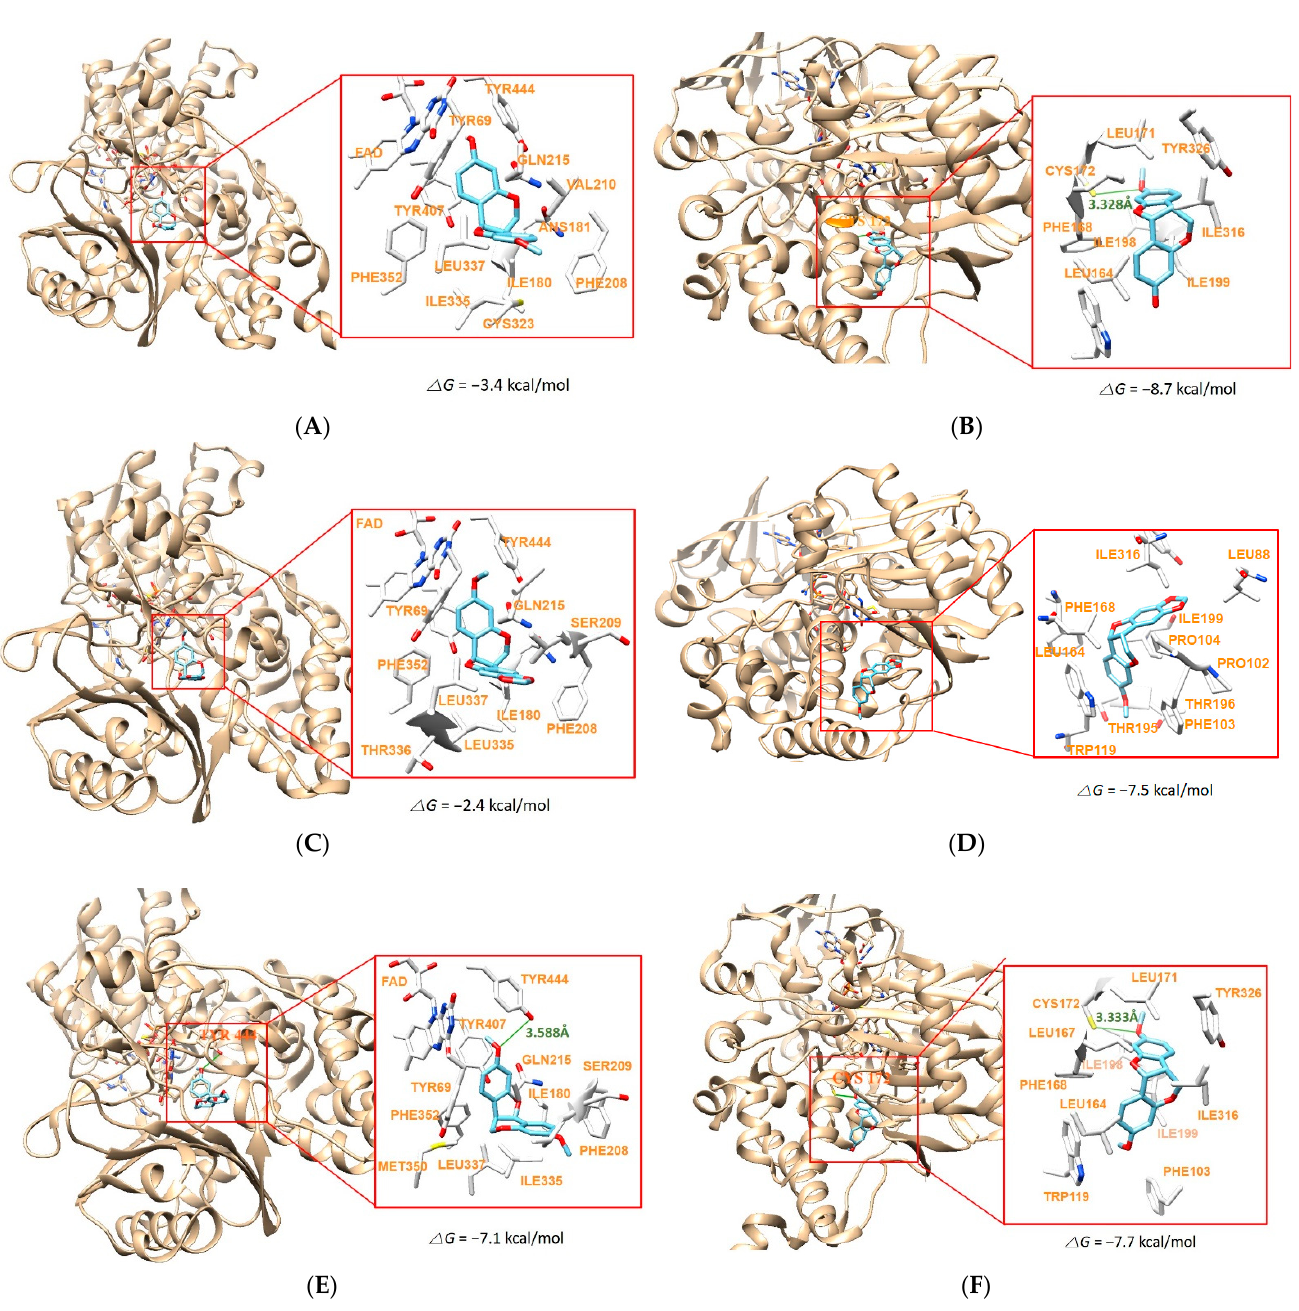
Figure 8. Docking simulations of 8 with hMAO-A (2Z5X) ( A ) and hMAO-B (4A79) ( B ), 12 with hMAO-A ( C ) and hMAO-B ( D ) and 13 with hMAO-A ( E ) and hMAO-B ( F ) as determined by AutoDock Vina. Green bars represent hydrogen bonds. Table 3. Docking scores and predicted hydrogen bond(s) of the three compounds with hMAO-A Table 4. Pharmacokinetic properties of medicarpin and or hMAO-B *.